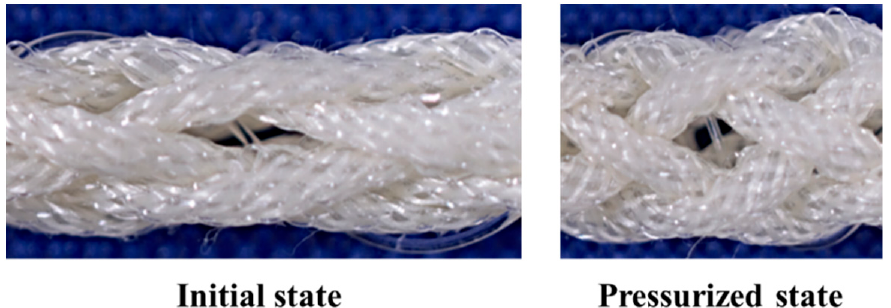
Figure 11. Enlarged view of the active string actuator.